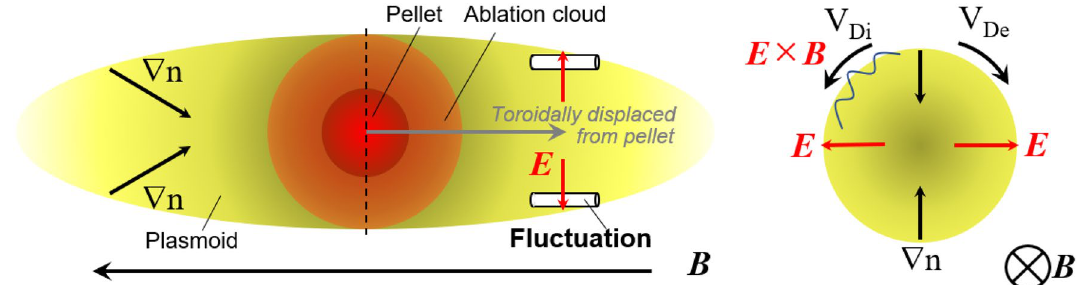
Figure 6. Schematic of fluctuation driving mechanism. For simplicity, the polarization electric field is not shown in this